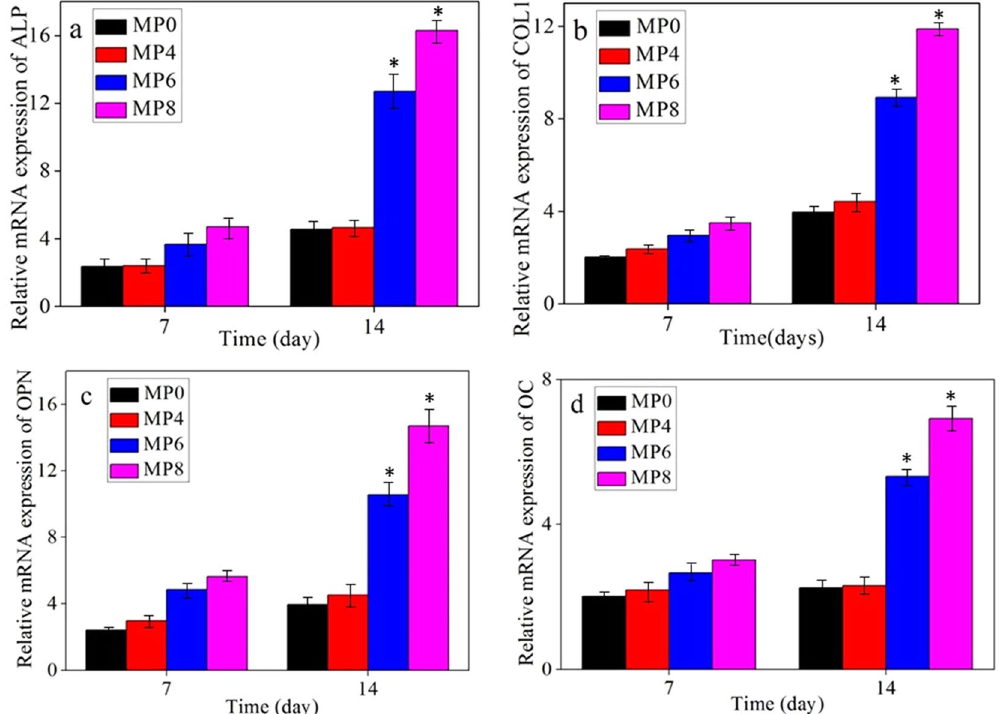
Figure 8. Relative mRNA expression of osteogenic differentiation-related genes: ALP ( a ), COL-1 ( b ), OPN ( c ) and OC ( d ) for MG63 cells grown on MP0, MP4, MP6 and